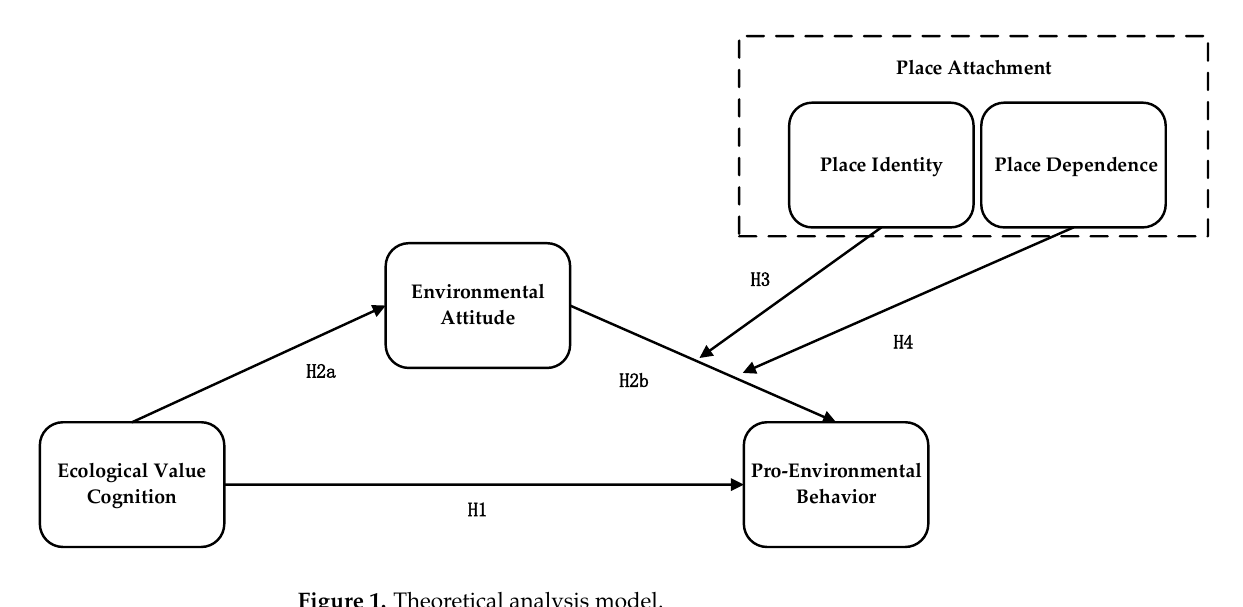
Figure 1. Theoretical analysis